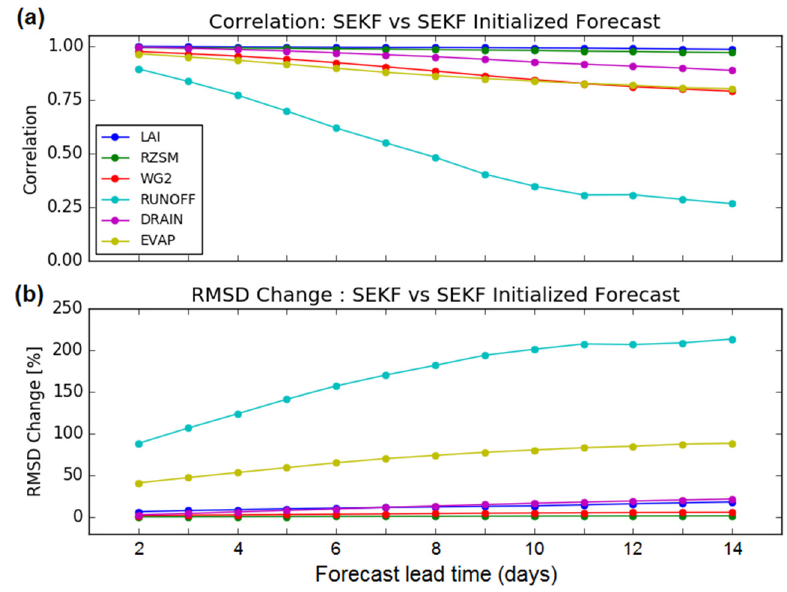
Figure 3. Comparison of forecasted LAI, root zone soil moisture (RZSM), WG2, runoff, drainage, and evapotranspiration (ET) variables initialized by the simplified extended Kalman filter (SEKF), with their values on the first day of forecast. The ( a ) correlation and ( b ) root mean squared difference (RMSD) relative changes with respect to FC1 score values are presented. These comparisons show the persistence of each variable with the use of atmospheric forecasts in the LDAS-Monde system over the contiguous United States (CONUS) for the 2017–2018 time period.